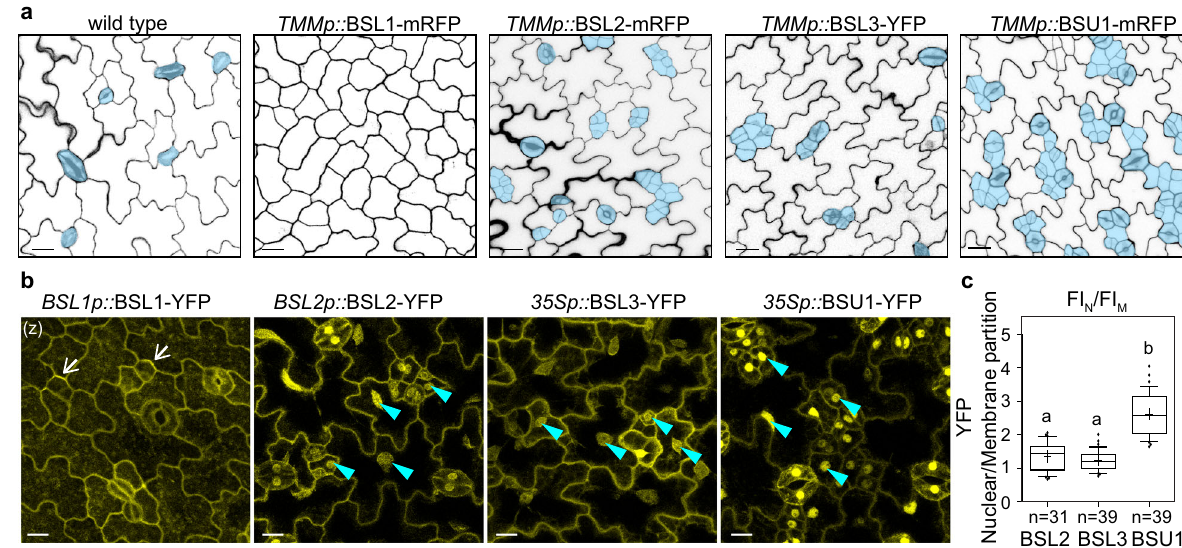
Fig. 2 Differential overexpression phenotypes and subcellular localization of BSL proteins in stomatal lineage cells. a Confocal images show stomatal phenotypes induced by overexpression of the BSL genes in the stomatal lineage cells (driven by the stomatal lineage TMM promoter) in 5-dpg adaxial cotyledon epidermis. Cell outlines were visualized with propidium iodide (PI)-staining. Stomatal lineage and guard cells are manually traced (blue). Data represent results of three independent experiments. Scale bars, 20 μ m. b Subcellular localization of the BSL proteins (yellow) in stomatal lineage cells in 3-dpg Arabidopsis adaxial cotyledon epidermis. Note, BSL1 is mainly cytoplasmic, close to the cell periphery and polarized (arrows); BSL2, BSL3, and BSU1 are cytoplasmic and nuclear (cyan arrowheads). Data represent results of three independent experiments. Scale bars, 10 μ m. (z), all images are z-stacked. c Quanti fi cation of nuclear/membrane (N/M) partition of BSL – YFP by measuring fl uorescence intensity (FI) of z-stacked images. Box plots show the fi rst and third quartiles, split by the median (line) and mean (cross). n , number of stomatal lineage cells used for quanti fi cation. Letters were assigned by ANOVA and Tukey ’ s multiple comparison test ( P ≤ 0.01). Exact P values are 0.2208 for BSL3 vs . BSL2 and 1.69335 e − 12 for BSU1 vs . BSL2, respectively, by unpaired t